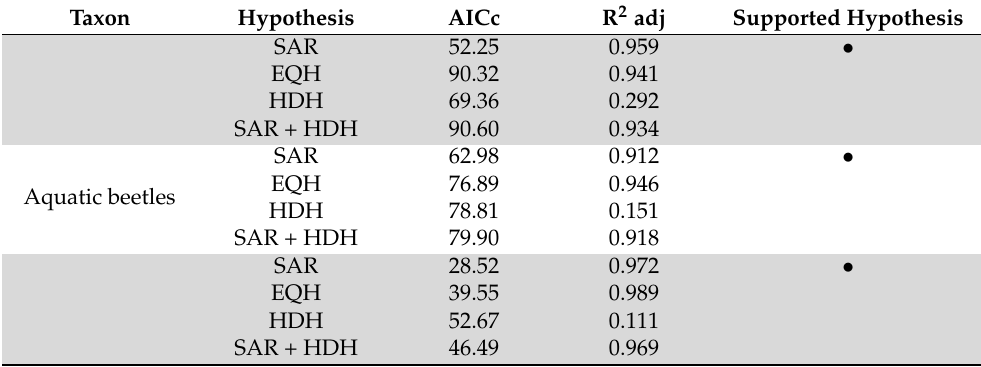
Table 3. Identification of the supported hypothesis by species richness of taxa modeled by the Negative exponential function according to AICc criterion. AICc: Akaike Information Criterion with a correction for finite sample; R 2 adj: Goodness-of-fit of the model according to the adjusted R 2